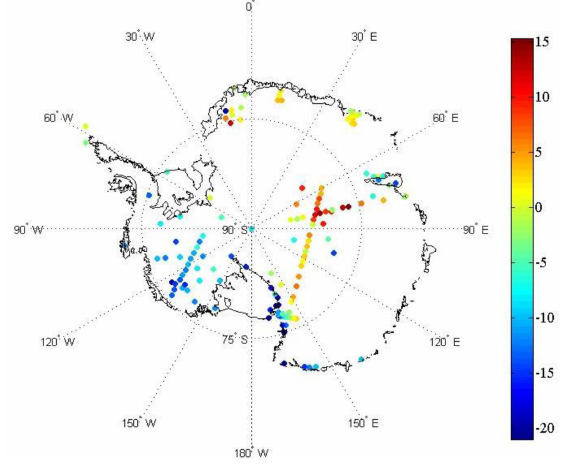
Figure 9. Density variations estimated from CRUST 1.0 crustal thickness